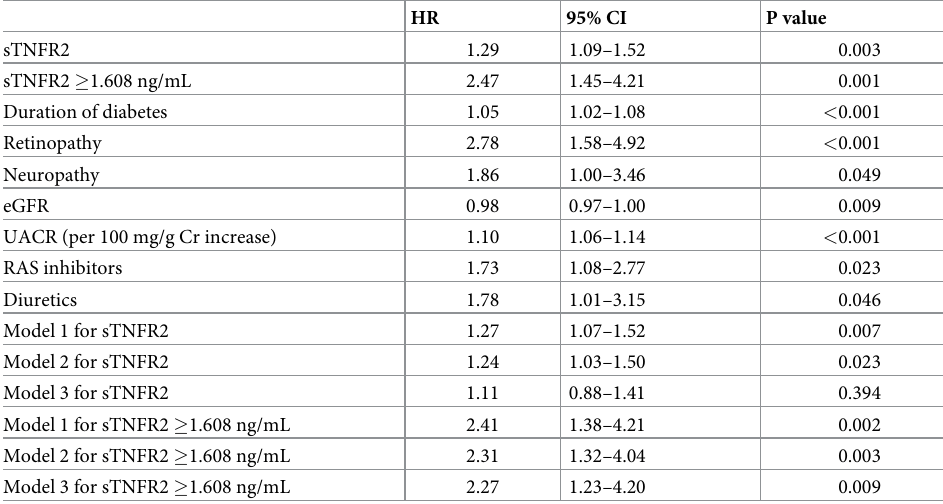
Model 1 for sTNFR2 Model 2 for